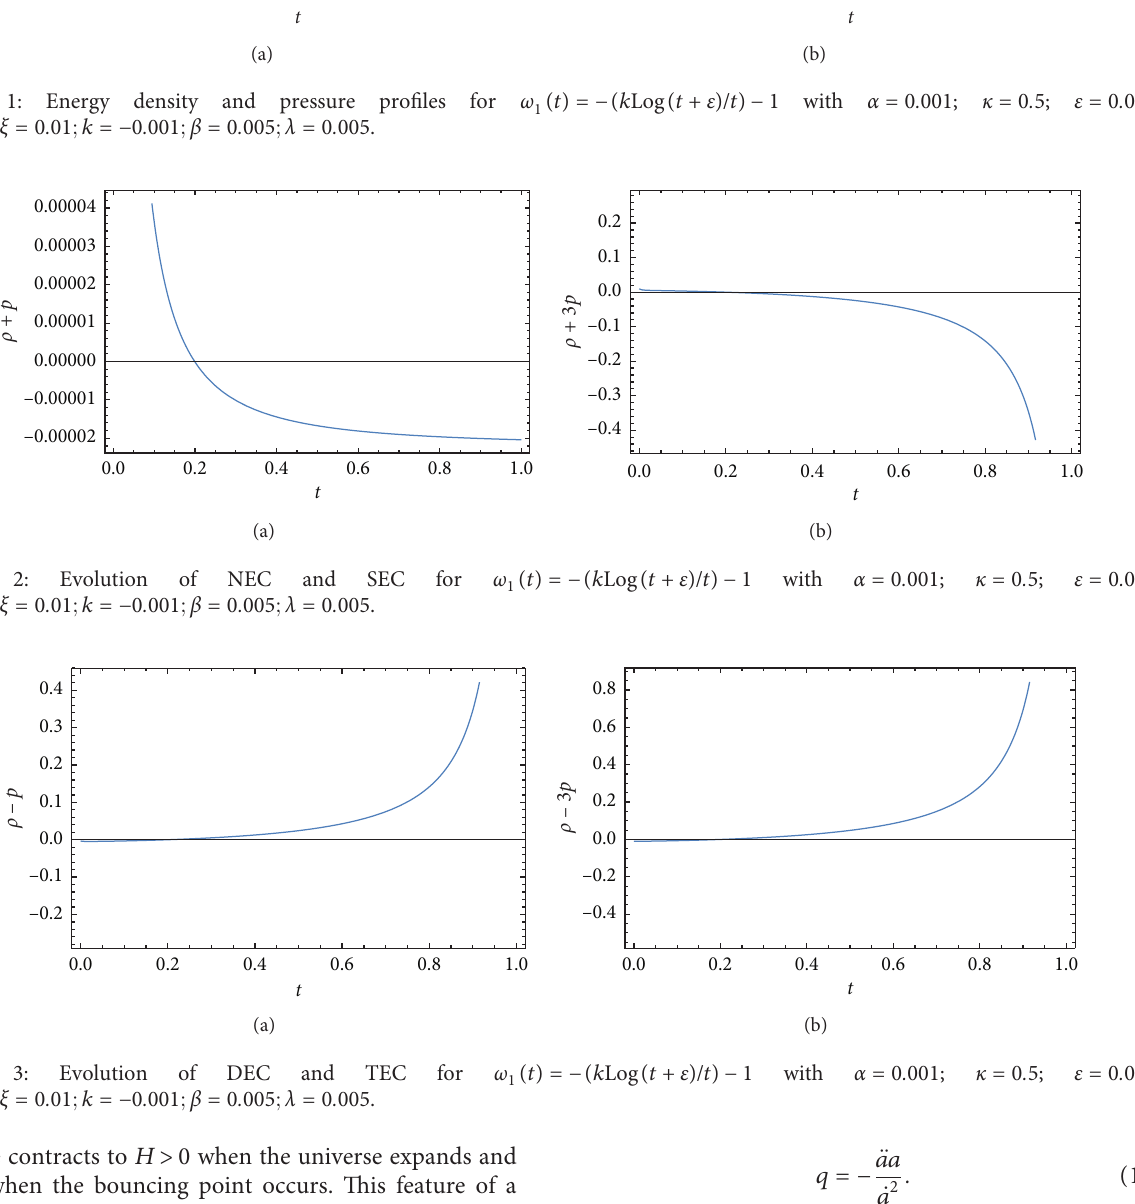
( t ) � − ( k Log ( t + ε ) / t ) − 1 with α � 0 . 001; κ � 0 . 5; ε � 0 . 001; 1